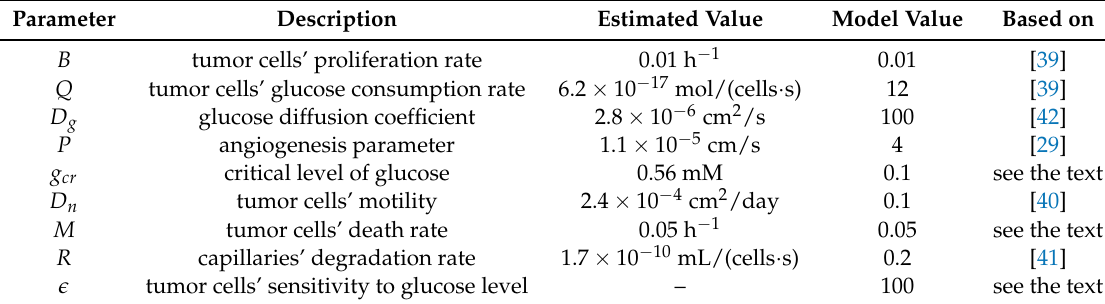
Table 1. Basic set of model